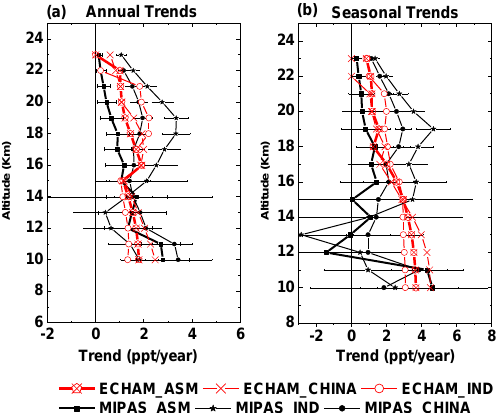
Figure 4: Vertical variation of trends obtained from monthly mean MIPAS-E PAN Figure 4. Vertical variation of trends obtained from monthly mean concentrations averaged for the period 2002-2011 and Ind38Chin73 simulations over the MIPAS-E PAN concentrations averaged for the period 2002–2011 Asian summer monsoon region, China and India (a) annual trends (b) seasonal (June- and Ind38Chin73 simulations over the Asian summer monsoon, September) trends. Chinese and Indian regions (a) annual trends (b) seasonal (June- September)